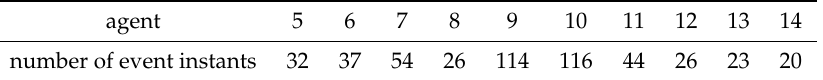
Table 4. Number of event instants of each agent ( τ = 0.1, 30